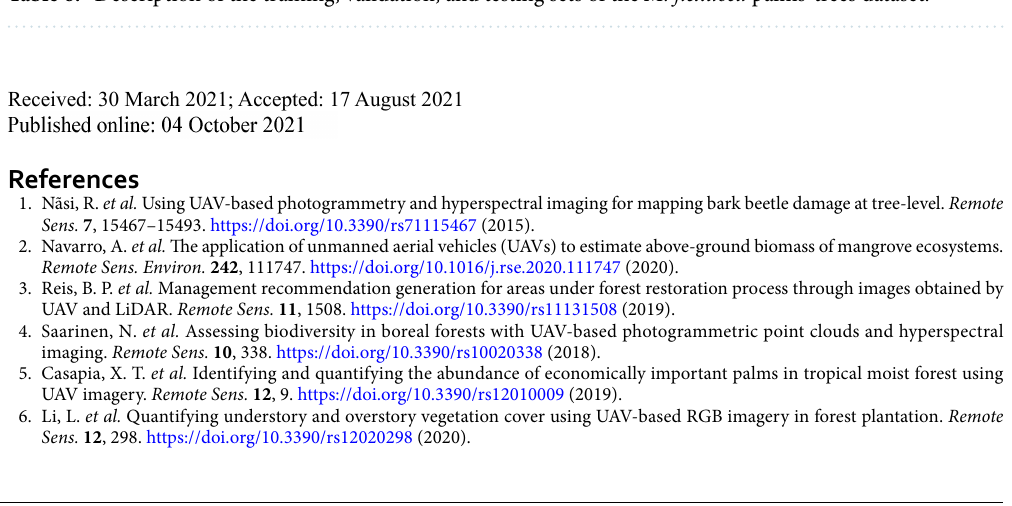
Table 6. Description of the training, validation, and testing sets of the M. flexuosa palms-trees dataset.